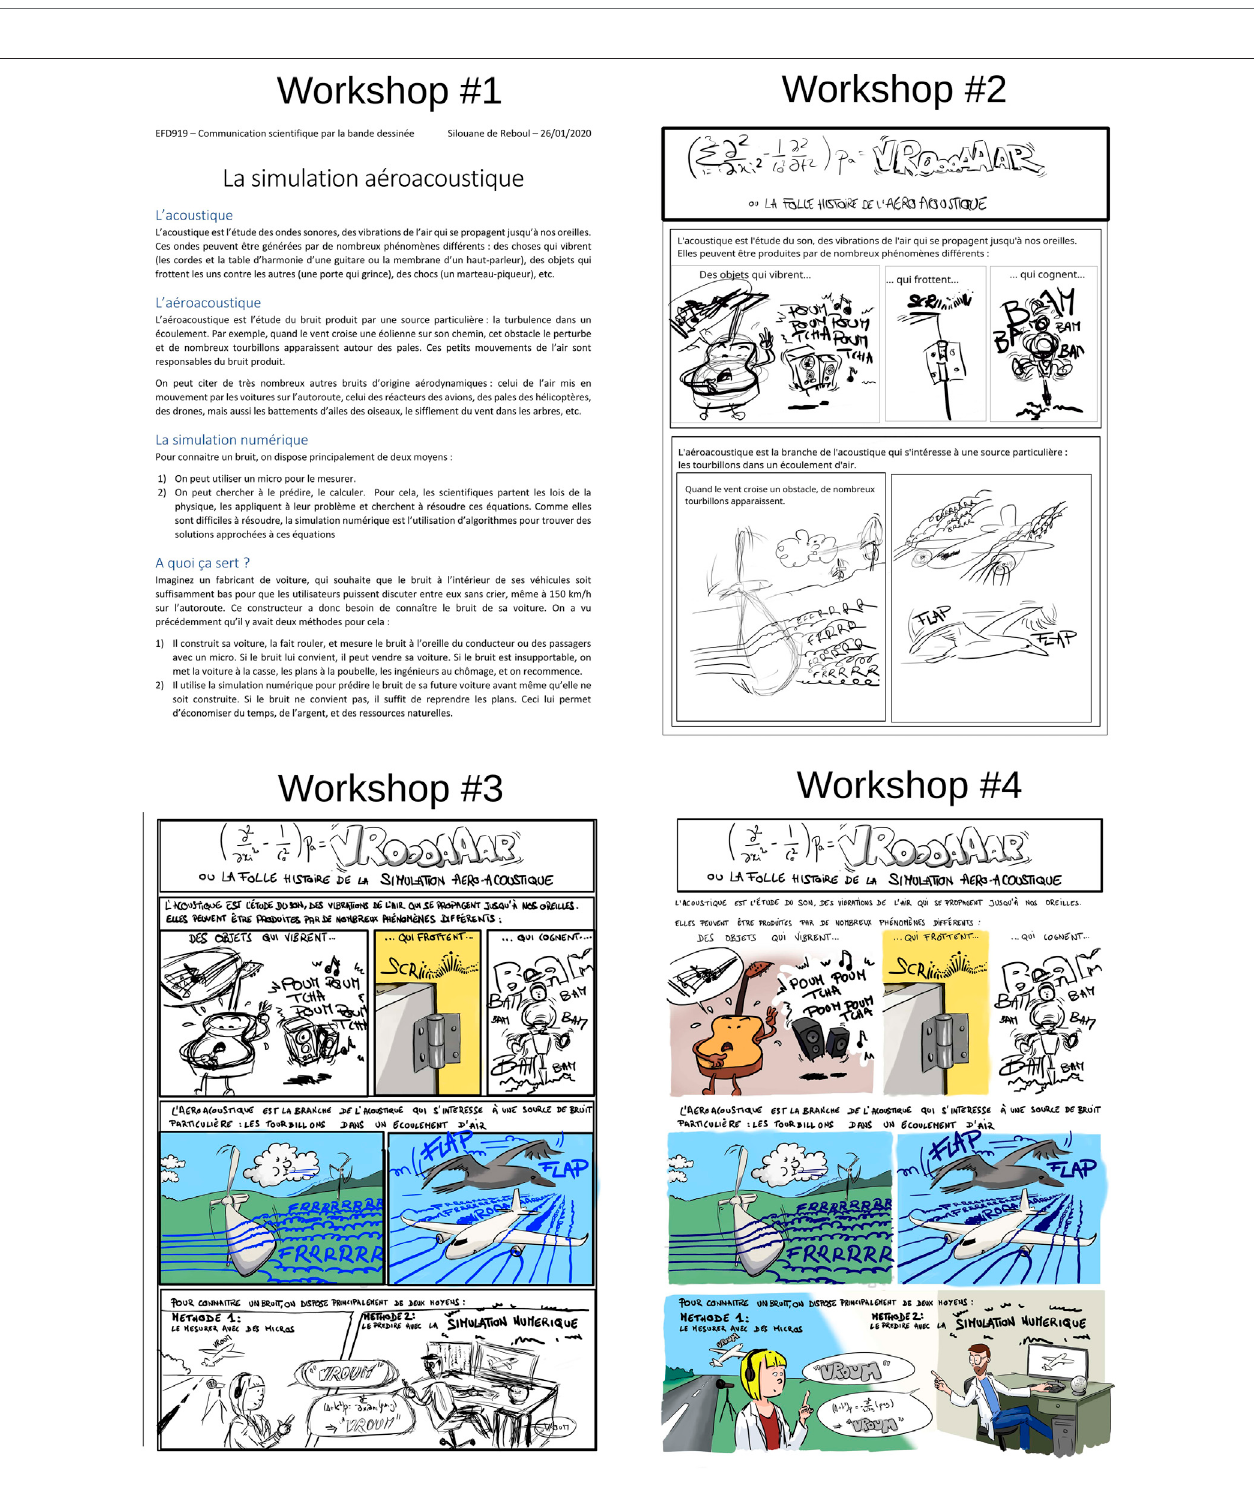
FIGURE1| Firstexampleofthecourseoutcomes:Workshop#1:initialpopularizedtext;Workshop#2: fi rstgraphicalbreakdown;Workshop#3:secondgraphical breakdown; Workshop #4: fi nal colorized work (Silouane de Reboul, La simulation aéroacoustique - Aeroacoustics simulation ).